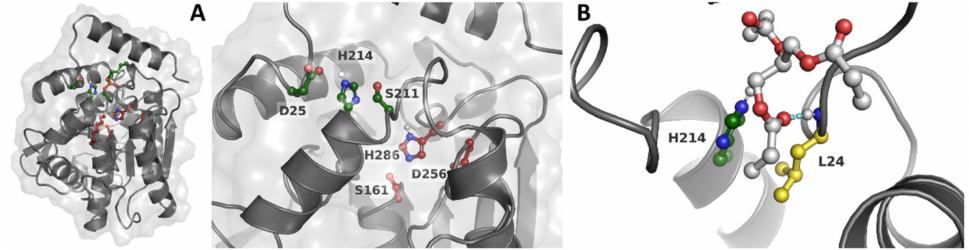
Figure 1. ( A ) Slice of the 3D structure of EH 1AB1 representing the main and artificial active sites. The C atoms are stained in maroon and dark green in the main active site and artificial active site, respectively. ( B ) Representative binding pose of glyceryl tripropionate (with C atoms stained in gray) where we can see the position of Leu24. Leu24 (in yellow) forms a hydrogen bond with the carbonyl O atom in the ester bond by the NH group in the backbone (indicated by a cyan dashed line) and is close to the His214